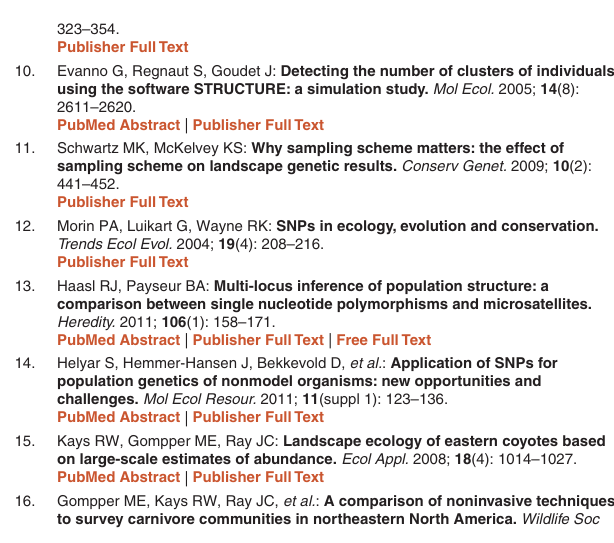
figshare : Data of genetic diversity in northeastern coyotes. http:// dx.doi.org/10.6084/m9.figshare.943483